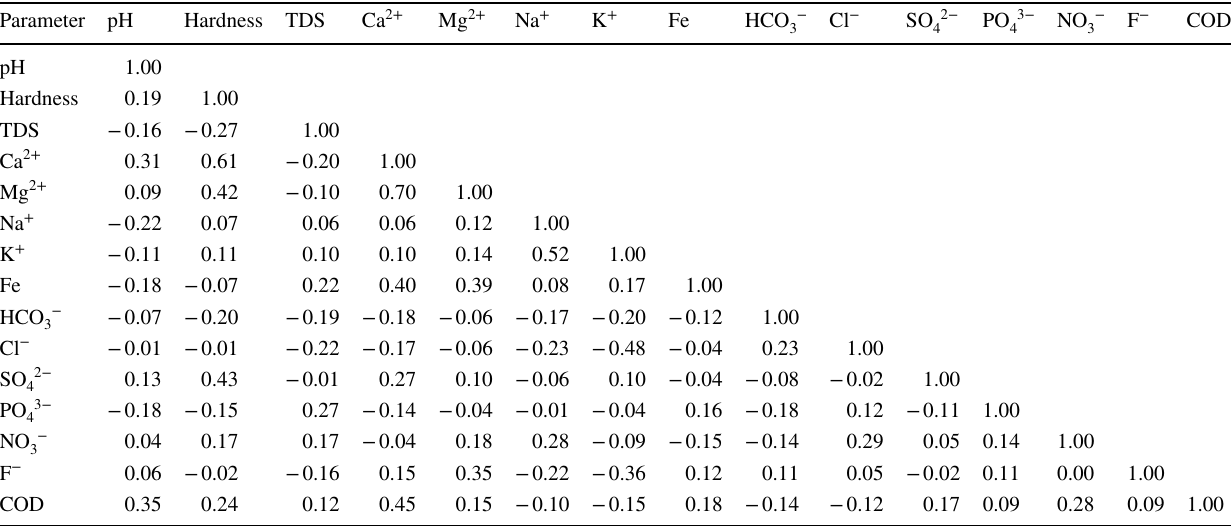
Table 12 Correlation matrix of the physicochemical parameters of the surface water samples in the wet season (taking average values) Parameter pH